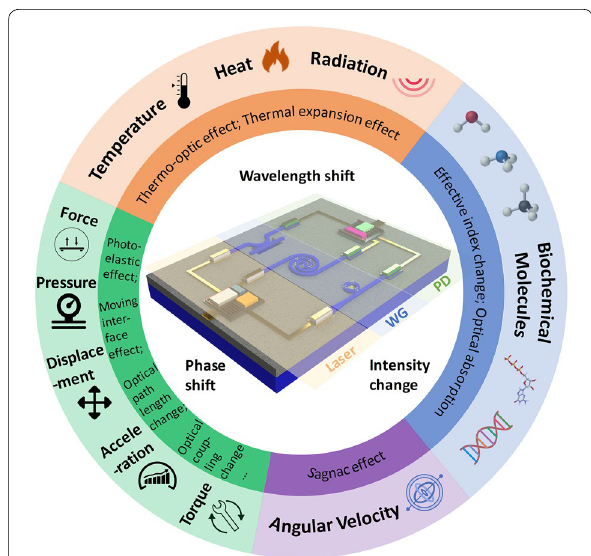
Fig. 1 Schematic illustration of the sensing mechanisms of a typical on-chip integrated infrared guided-wave nanophotonic sensing system. WG guided-wave nanophotonic device, PD